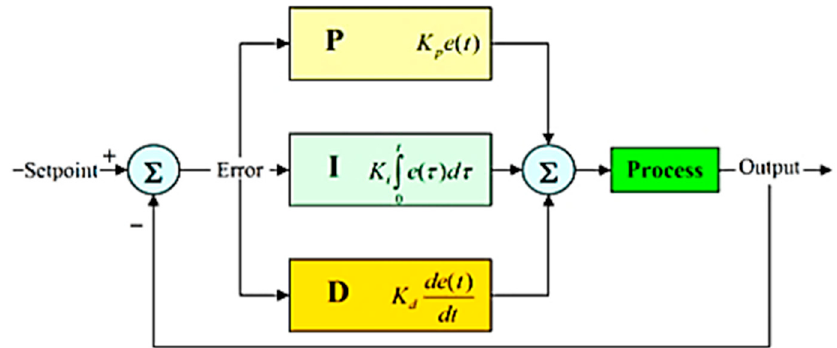
Figure 2. Calculation of correction value in a PID loop.